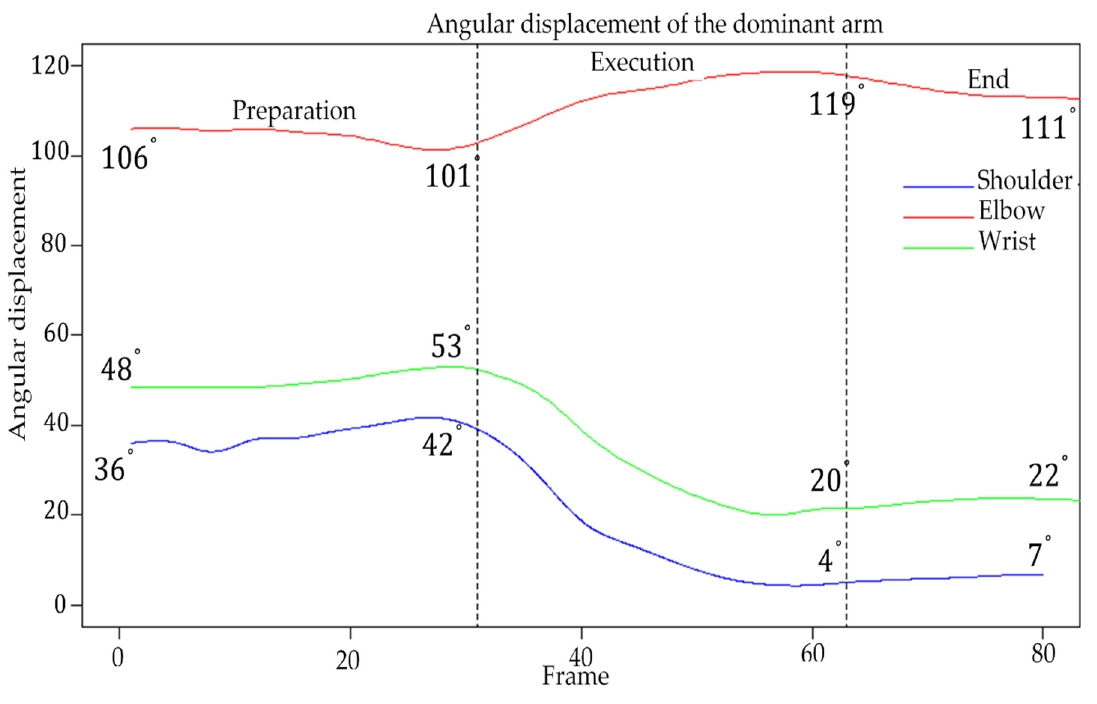
Figure 6. The average value of angular displacement patterns of twenty subjects for ( a ) the support arm and ( b ) the dominant arm during the three phases.